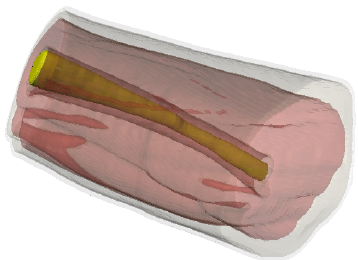
Fig. 17: 3D-view of thigh after